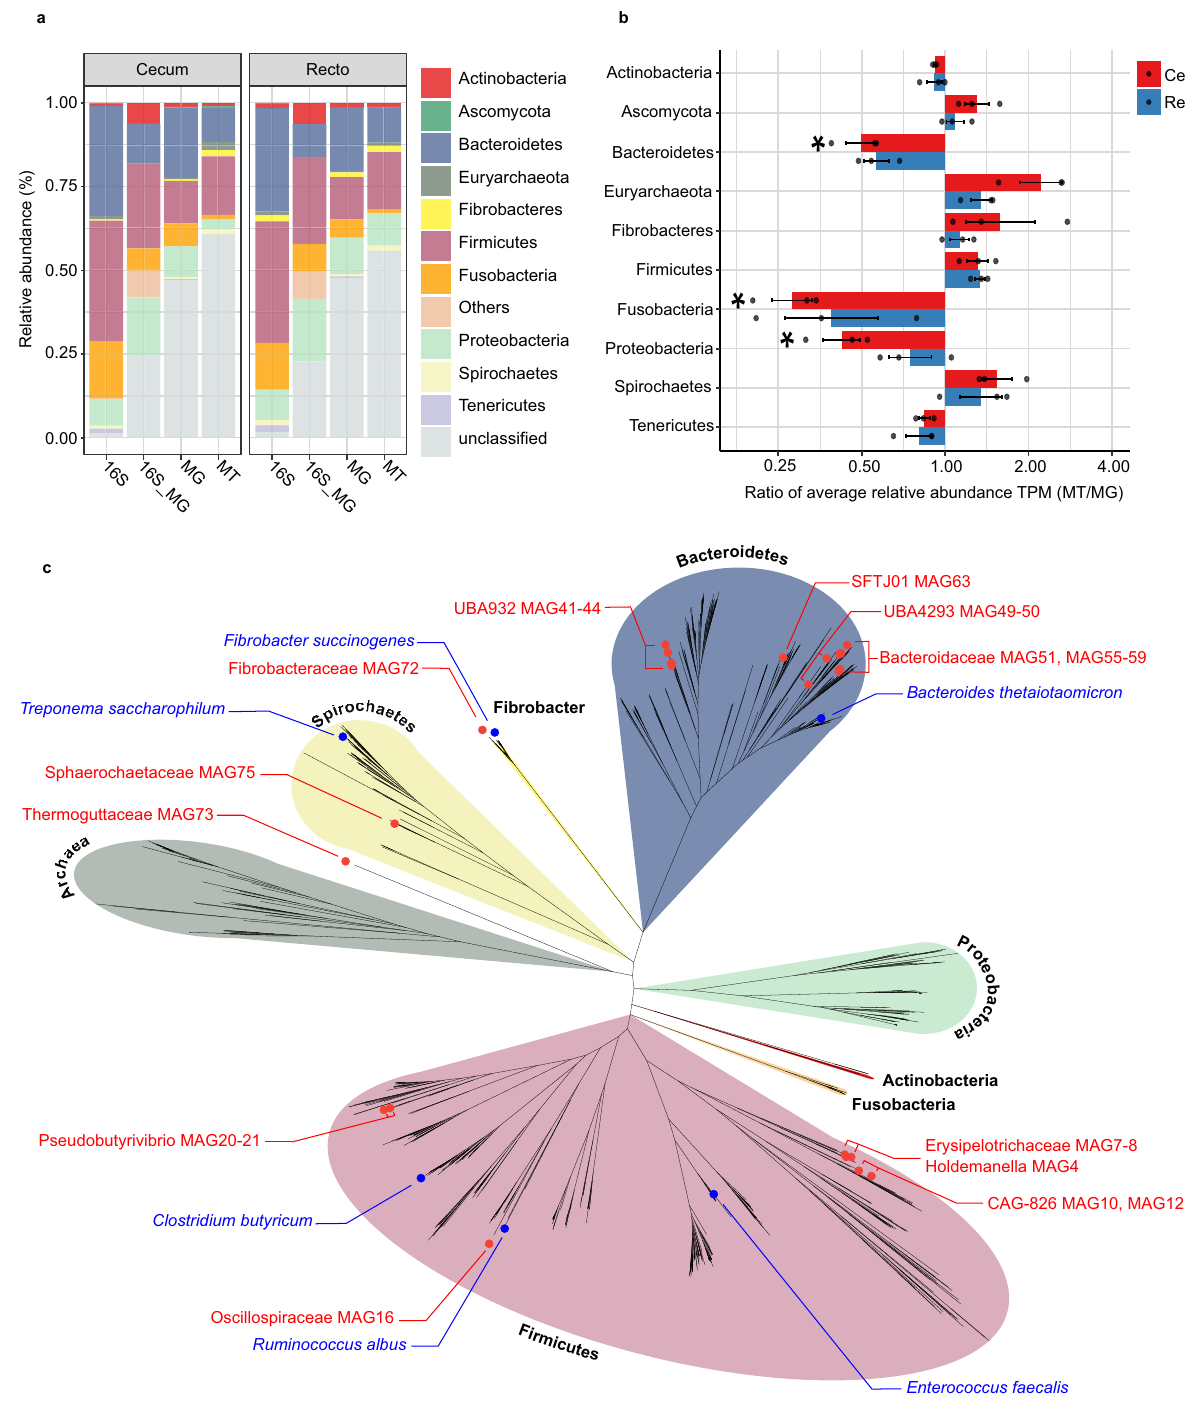
Fig. 2 Microbial taxonomic composition of capybara gut microbiome. a Relative phyla abundance based on 16S rRNA gene target sequencing (16S), 16S rRNA recovered from metagenome (16S_MG), whole metagenome (MG) and metatranscriptome (MT) reads. b Ratio of average relative phyla abundance (Transcripts Per Million - TPM) of metatranscriptome to metagenome (MT/MG), expressed in a log 2 scale. Bars marked with an asterisk (*) are signi fi cantly different from MT/MG = 1 (two-tailed t- test, P -value with false discovery rate correction for multiple tests, 0.05 was used as the threshold of signi fi cance level). The data represent the average of three independent experiments ( n = 3), using fresh samples collected from the cecum and recto of three wild animals by abdominal surgical procedure. c Phylogenetic tree of the 79 recovered metagenome-assembled genomes (MAGs) from capybara microbiota, including related genomes publicly available. The capybara microbiota taxonomic novelties and some reference genomes are highlighted with red and blue circles, respectively. Source data are provided as a source data fi